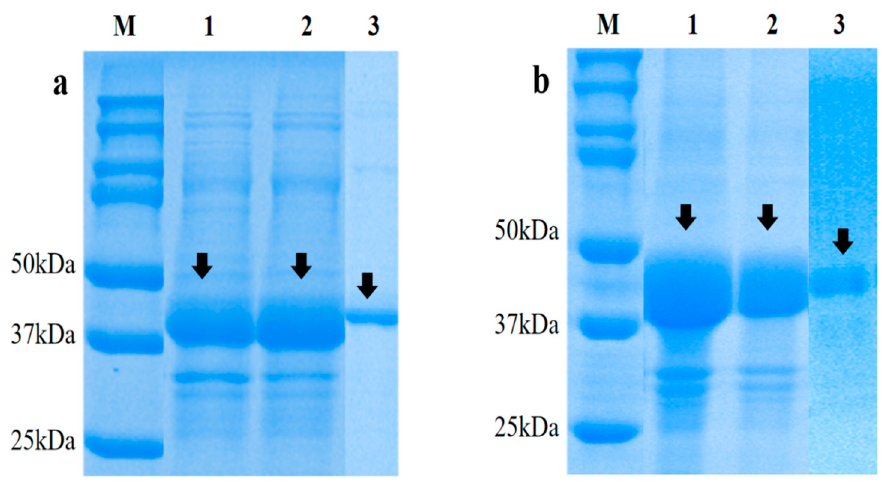
Figure 3. Expression and purification of r Em SAG10 ( a ) and r Em SAG11 ( b ). M: Bio-red protein molecular weight standard; lanes 1 and 2 in ( a ) are r Em SAG10 inclusion bodies for the solubility analysis; lane 3 in ( a ) is purified r Em SAG10. Lanes 1 and 2 in ( b ) are r Em SAG11 inclusion bodies for the solubility analysis, and lane 3 in ( b ) is purified r Em SAG11.